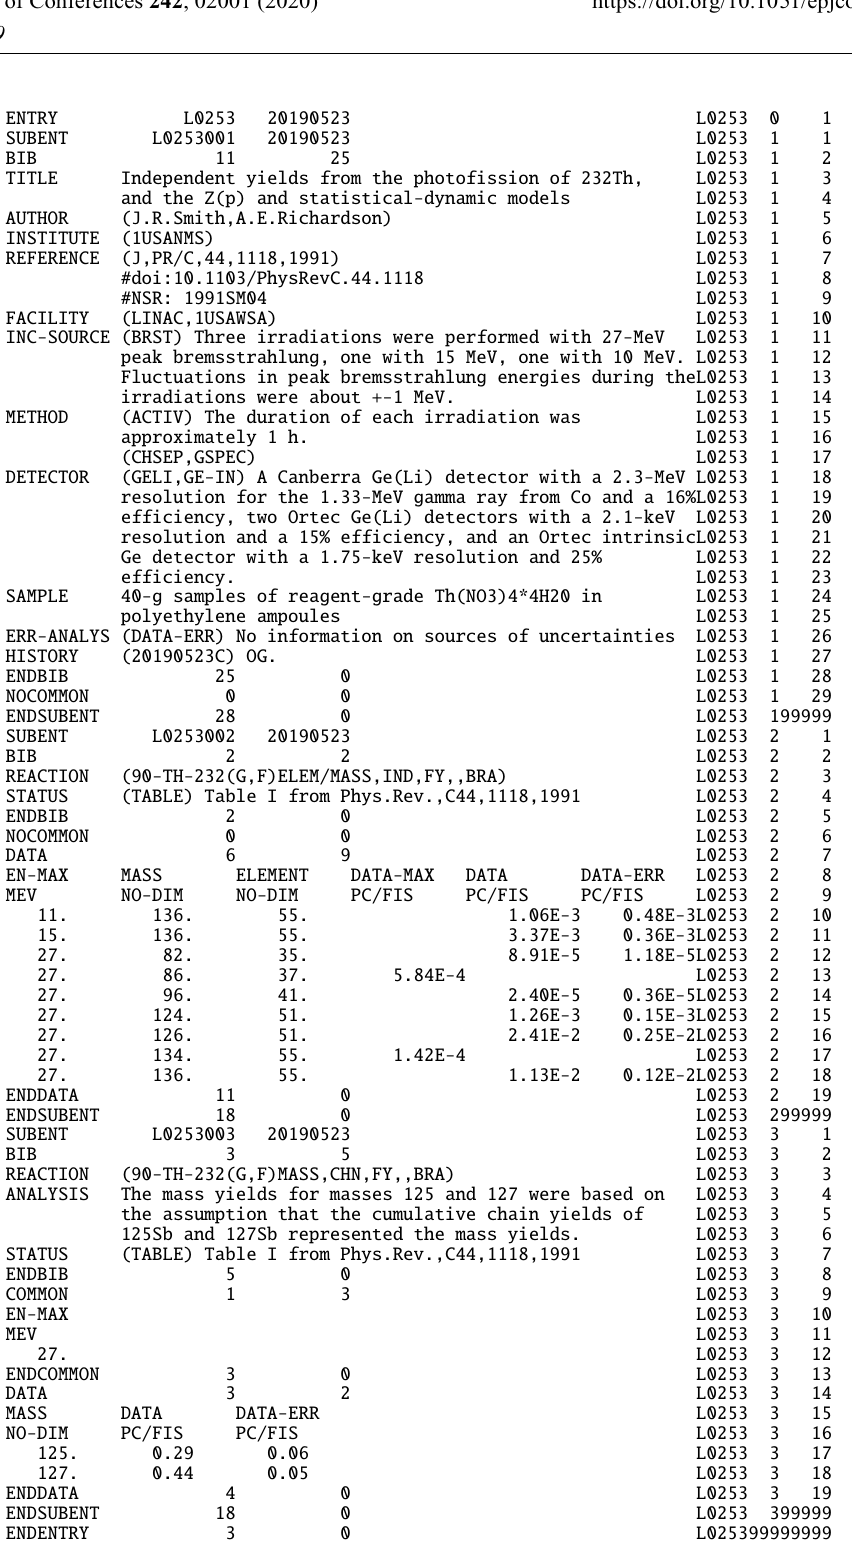
Figure 5. EXFOR compilation of 232 Th( γ ,F) work of J.R. Smith and A.E. Richardson